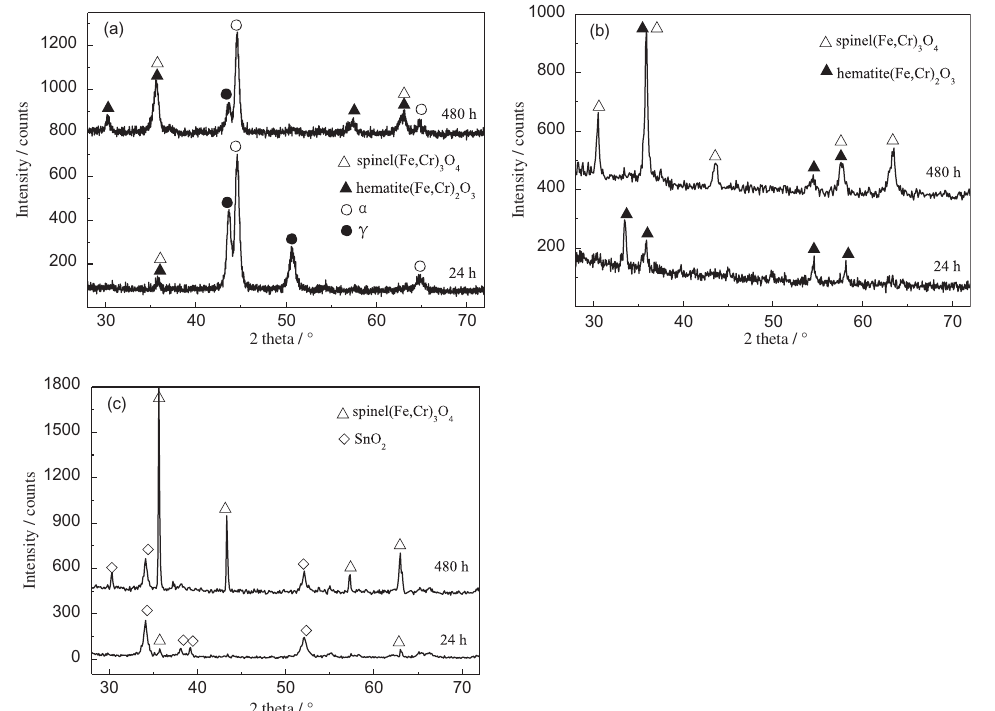
Figure 4: GIXRD and SR-GIXRD patterns of the oxide films for 304 stainless steel after 24 and 480 h exposure to 300°C water, (a) GIXRD, without (Fe, Cr)Sn 2 adhesion, (b) SR-GIXRD, without (Fe, Cr)Sn 2 adhesion, (c) SR-GIXRD, with (Fe, Cr)Sn 2